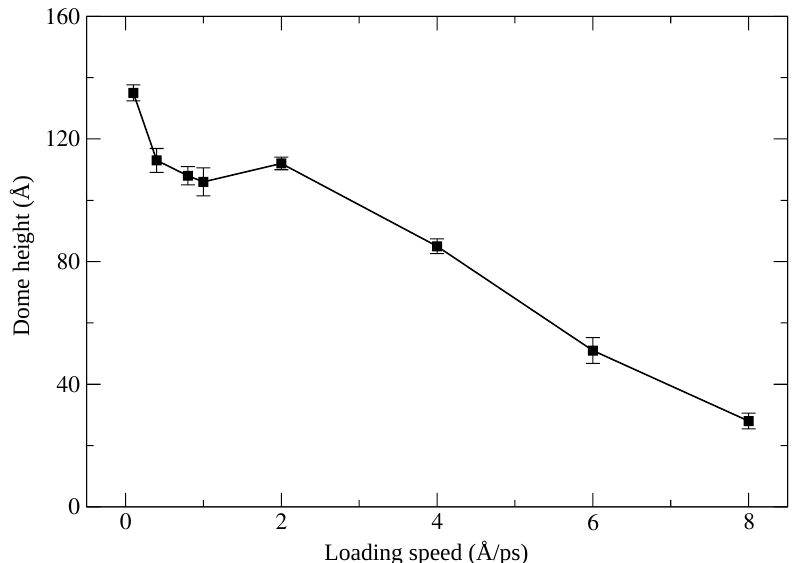
Figure 7. The trend of averaged dome-height of the workpiece against different loading speeds with standard error bars.